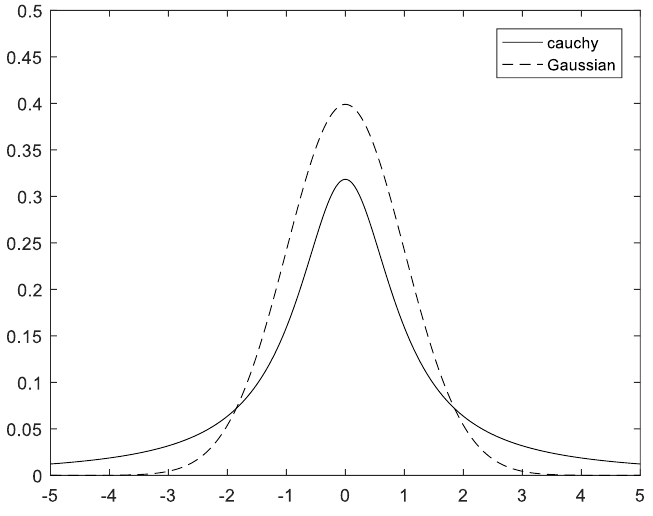
Figure 4. Curves of the probability density functions.